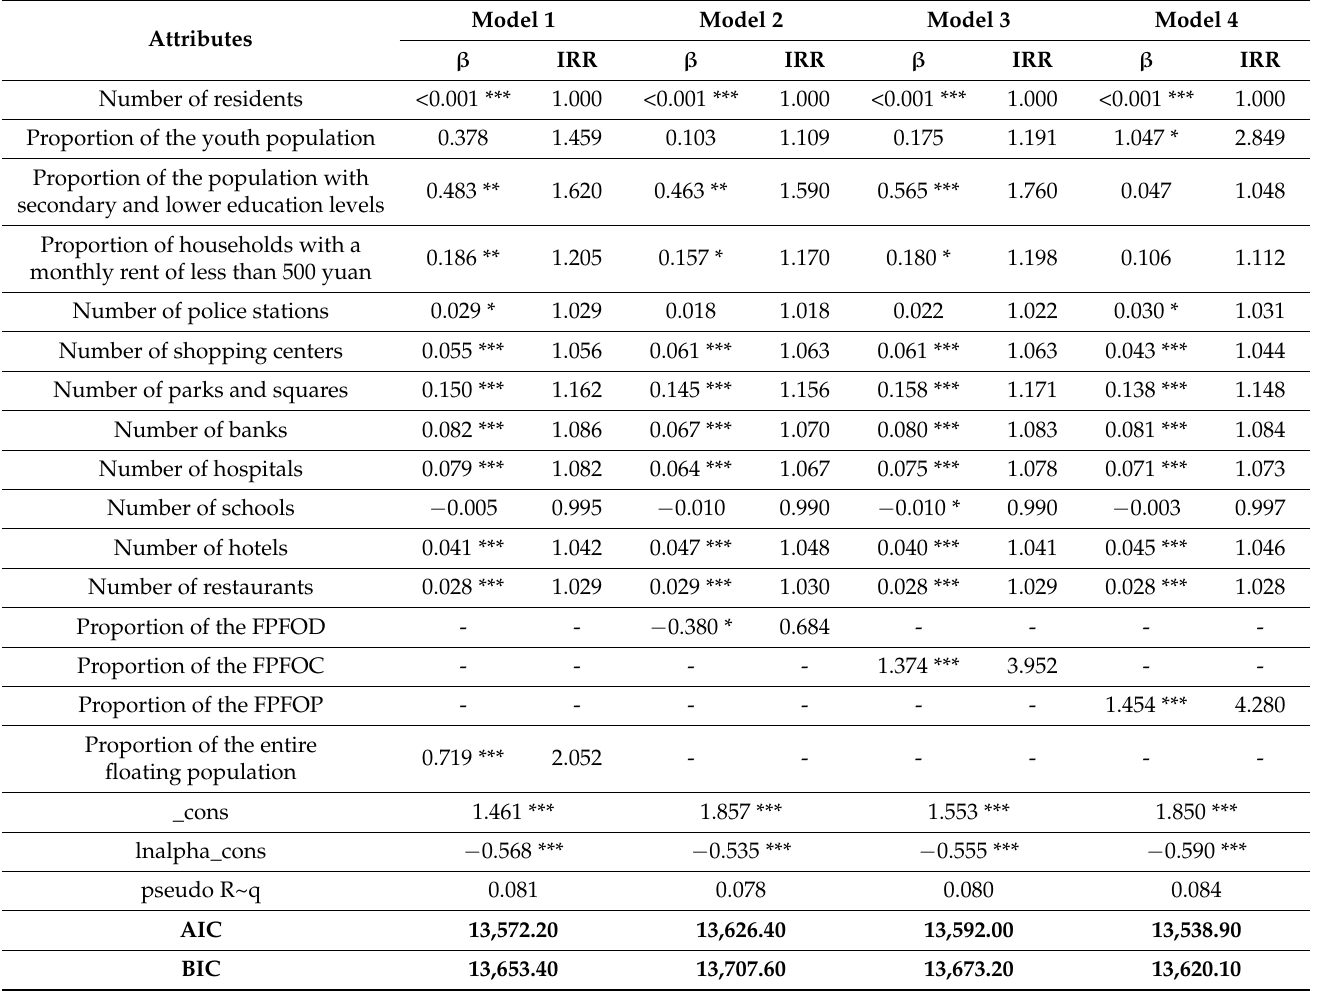
Table 2. Results of Model